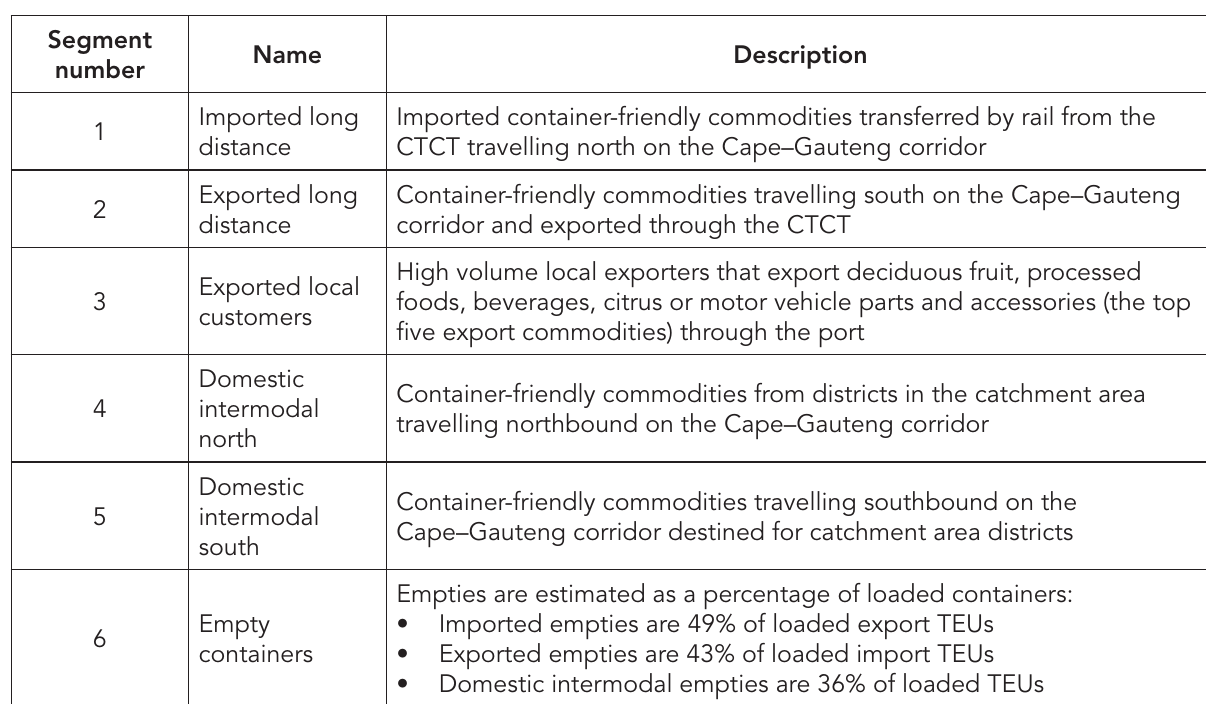
Table 1: Segmented container freight